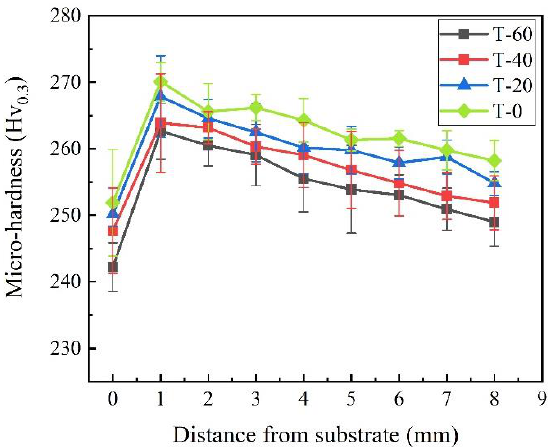
Figure 11. Microhardness curves of LMD-Al 0.5 FeCoCrNi walls under different heat dissipation rates.